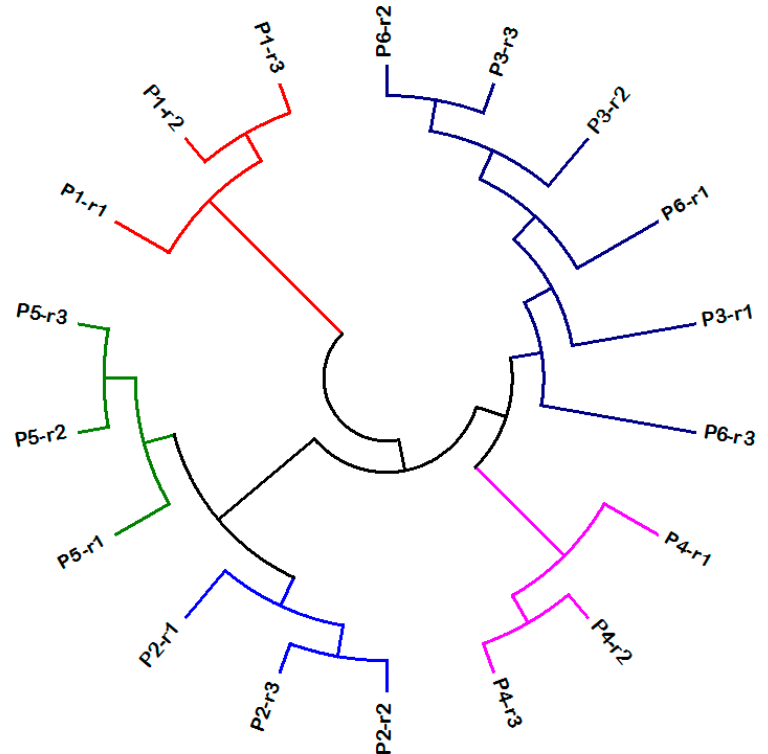
Figure 3. Cluster analysis using the maximum composite likelihood model based on ITS sequencing of the three replicates (r1 to r3) of each six seed lots (P1 to P6) of Conyza spp. P1 ( C. bonariensis ) = Tal-al-Ramel site, P2 ( C. canadensis ) and P3 ( C. bonariensis ) = University of Jordan Research Station site, P4 ( C. bonariensis ) and P5 ( C. canadensis ) = al-Twal site and P6 ( C. bonariensis ) = University of Jordan Campus